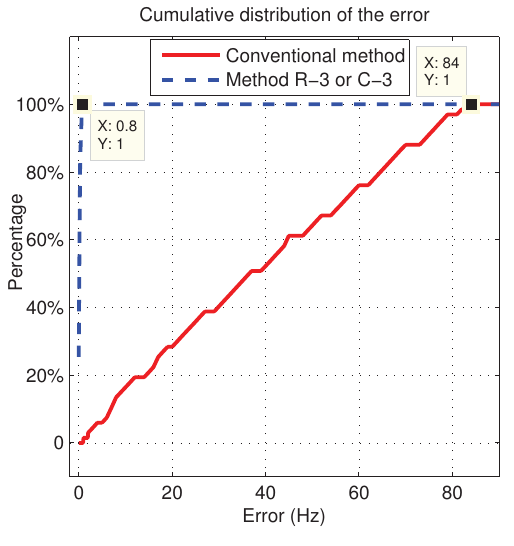
Cumulative distribution of the frequency errors (comparison between the conventional and methods R-3 and